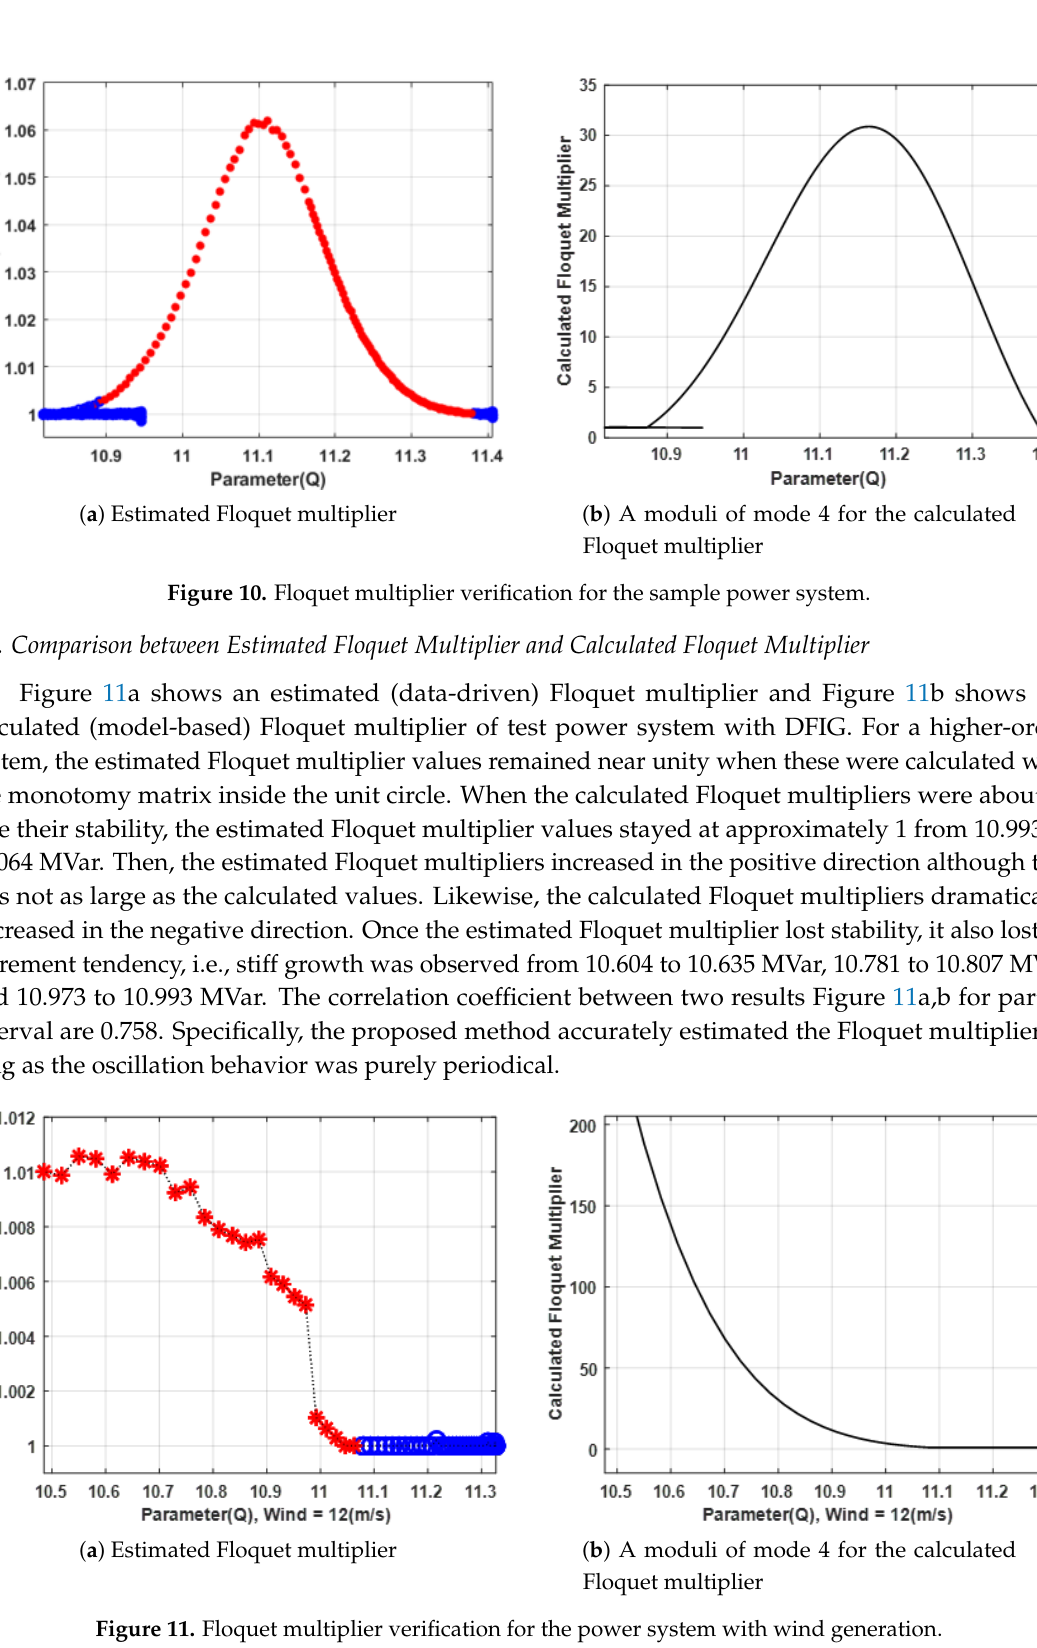
Figure 11. Floquet multiplier verification for the power system with wind